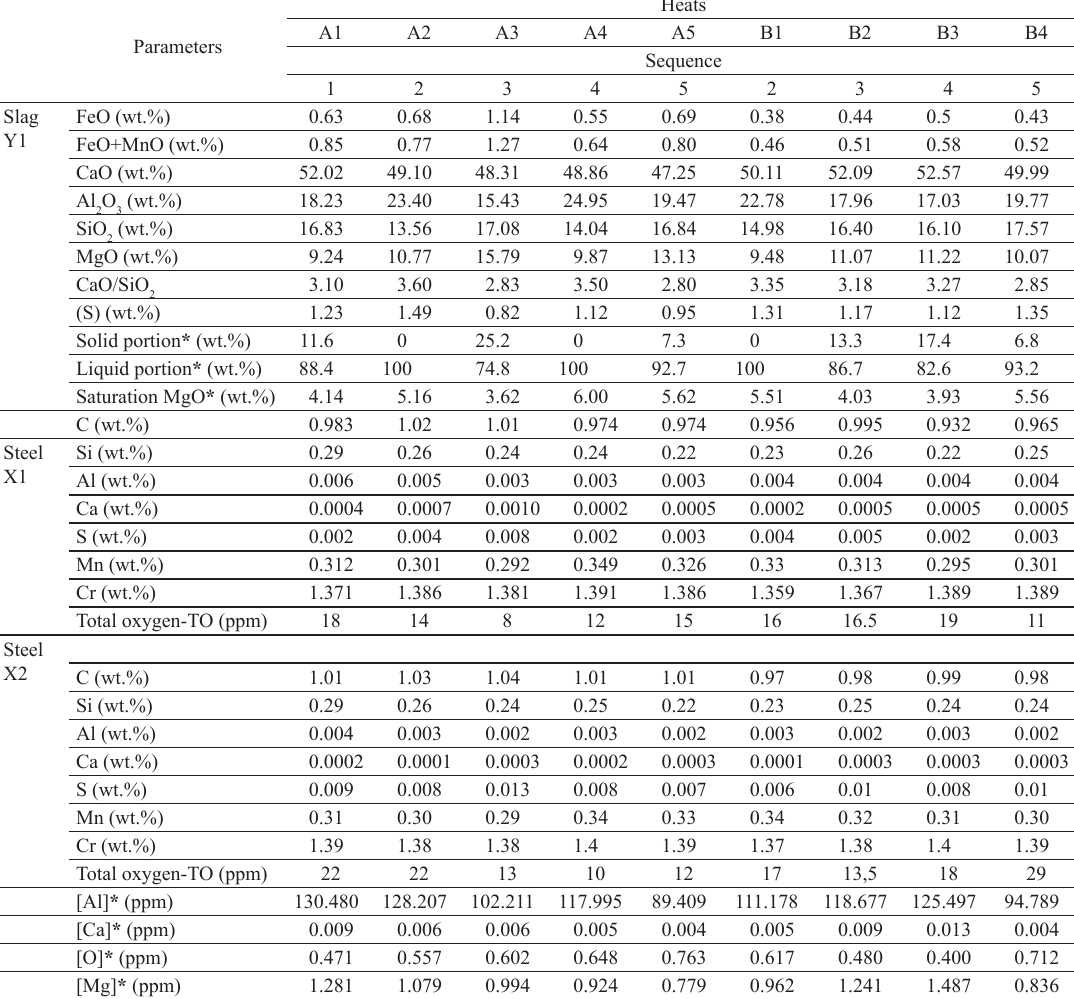
Table 1. Summary of the main slag and steel parameters measured and calculated of the analyzed samples.